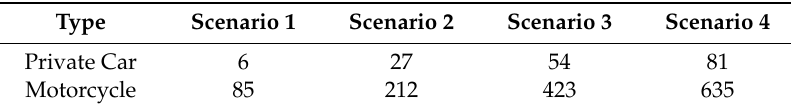
Table 5. EV number at load